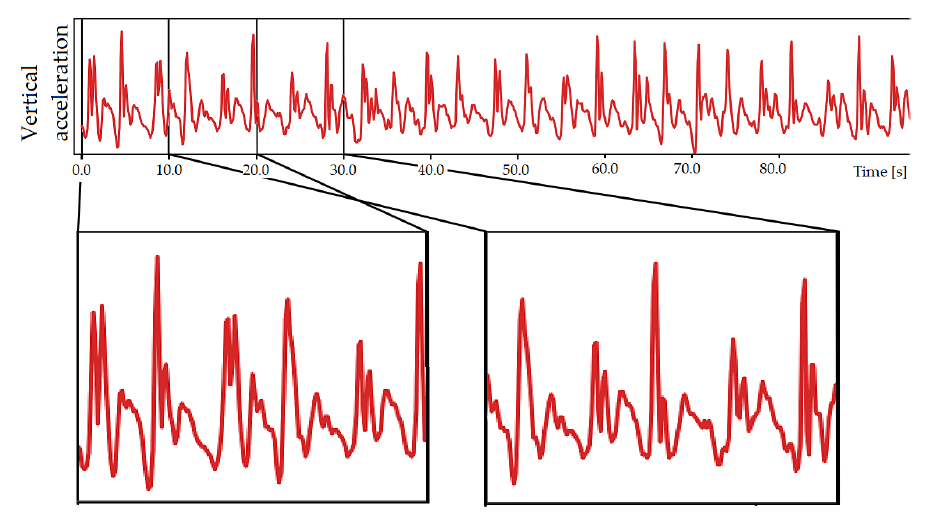
Figure 4. Example of sequence splitting for the train dataset. A duration of 20 s is chosen with 10 s overlapping.